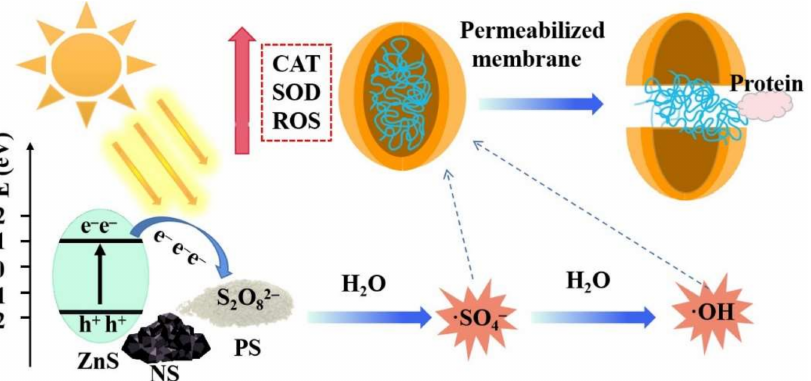
Figure 7. Graphical illustration of the bacterial spore inactivation mechanism in the Vis/NS/PS